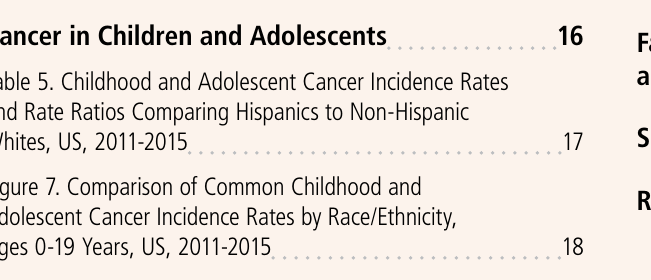
Figure 1. Hispanic Population Distribution as a Percent of Total County Population 1 Table 1. Probability (%) of Developing Invasive Cancer during Selected Age Intervals by Race/Ethnicity and Sex, US, 2013-2015 2 Table 2. Leading Causes of Death among Hispanics and Non-Hispanic Whites, US, 2016 Figure 2. Leading Sites of New Cancer Cases and Deaths Among Hispanics – 2018 Estimates Figure 3. Trends in Incidence and Death Rates for All Cancers Combined among Hispanics, US, 1990-2016 5 Table 3. Incidence and Mortality Rates for Selected Cancers by Race and Ethnicity, US, 2011-2016 6 Table 4. Cancer Incidence and Death Rates for Selected Cancers, Puerto Rico, 2011-2015 Major Cancer Sites Figure 4. Trends in Incidence and Death Rates among Hispanics for Selected Cancers, US, 1990-2016 Figure 5. Stage Distribution for Selected Cancers in Hispanics and Non-Hispanic Whites, US, 2011-2015 Figure 6. Five-year Cause-specific Survival Rates (%), US, 2008-2014 Cancer Sites with Higher Rates among Hispanics 13 Cancer in Children and Adolescents Table 5. Childhood and Adolescent Cancer Incidence Rates and Rate Ratios Comparing Hispanics to Non-Hispanic Whites, US, 2011-2015 Figure 7. Comparison of Common Childhood and Adolescent Cancer Incidence Rates by Race/Ethnicity, Ages 0-19 Years, US, 2011-2015